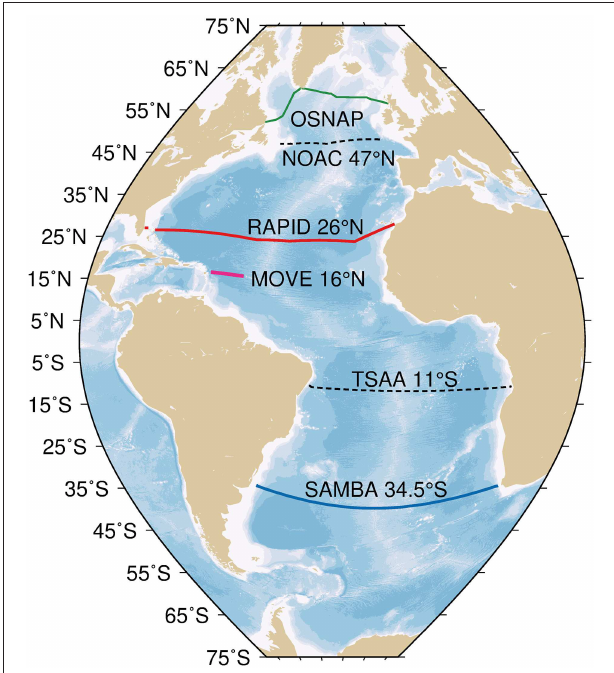
FIGURE 3 | Observing arrays in the Atlantic with AMOC transport estimates from OSNAP (green, from 2014), NOAC 47 ◦ N (black dashed, still to be produced), RAPID 26 ◦ N (red, from 2004), MOVE 16 ◦ N (magenta, from 2000), TSAA 11 ◦ S (black dashed, still to be produced), and SAMBA 34.5 ◦ S (blue, from